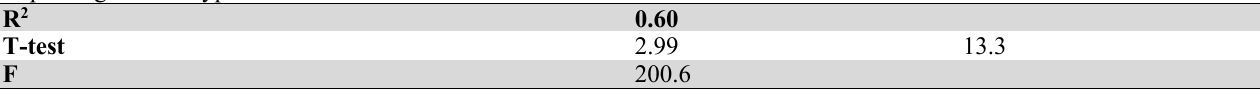
Simple Regression Hypothesis 2